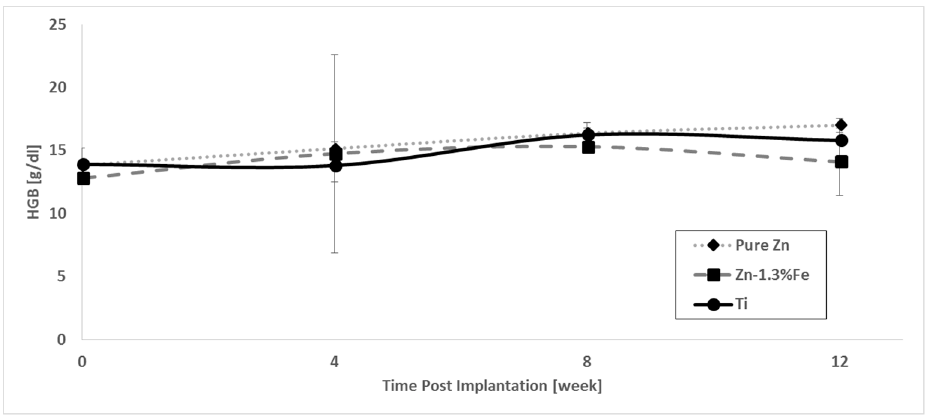
Figure 13. Hemoglobin (HGB) level pre- and post-implantation.